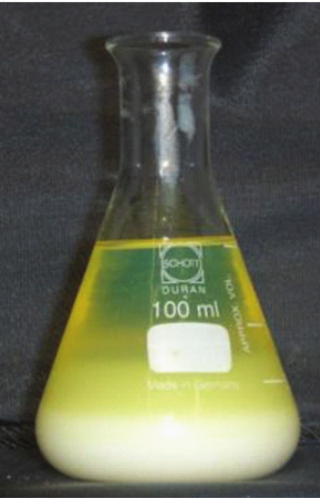
Figure 1: Heterogeneous mixture at room temperature, mixture of 40% fat and 60%